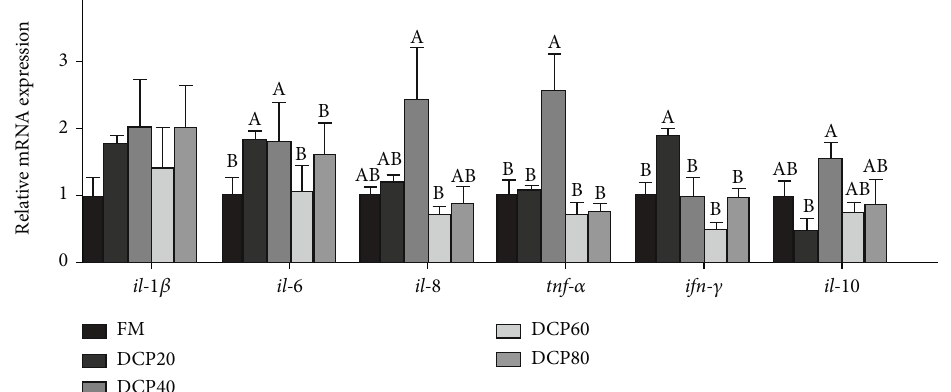
Figure 6: Relative expression of genes related to hepatic in fl ammatory cytokines of juvenile fed the trial diets ( means ± SEM, n = 3 ). il-1 β : interleukin-1 β ; il-6 : interleukin-6; il-8 : interleukin-8; il-10 : interleukin-10; tnf- α : tumor necrosis factor- α ; ifn- γ : interferon- γ . No repetition of letters in the equal index means signi fi cant di ff erences ( P < 0 : 05